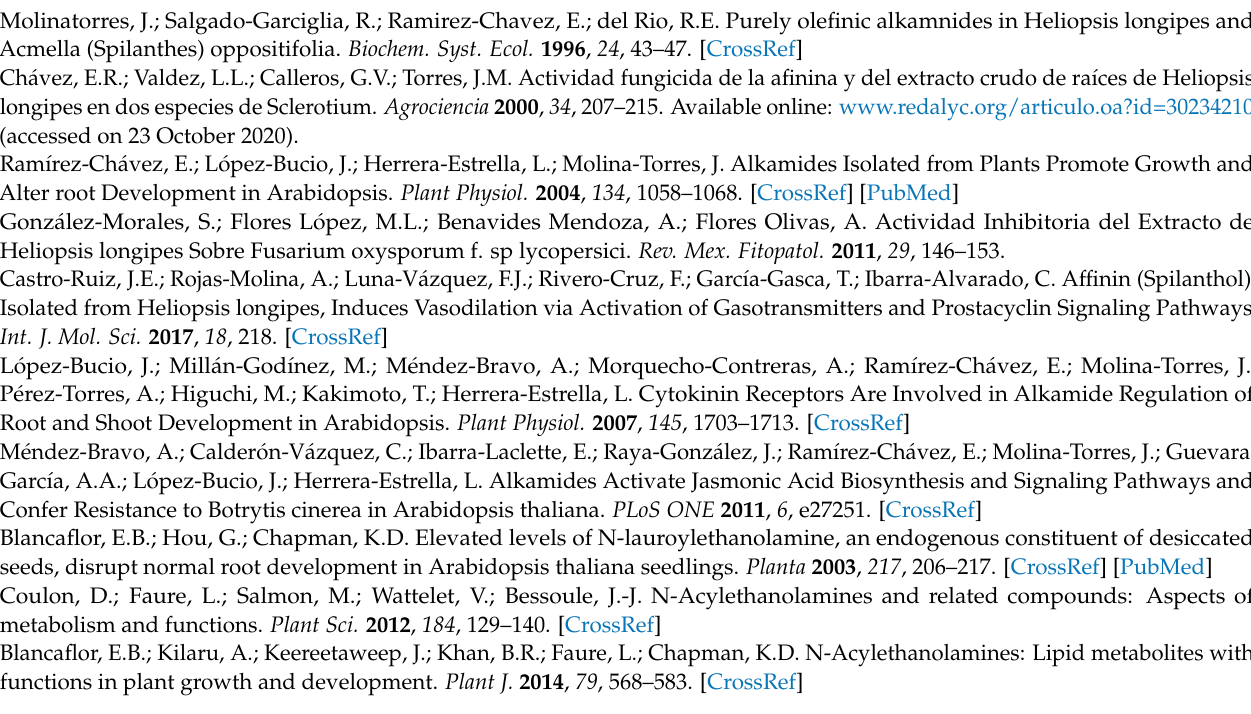
Figure S4: Box plot of the normalized relative abundances of the thirty-seven metabolites detected with the SAM analysis in